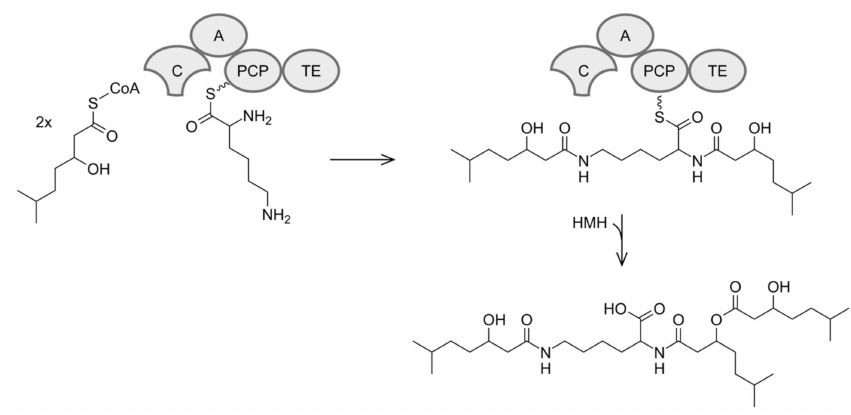
Figure 5. Proposed biosynthesis exemplarily for dudomycin